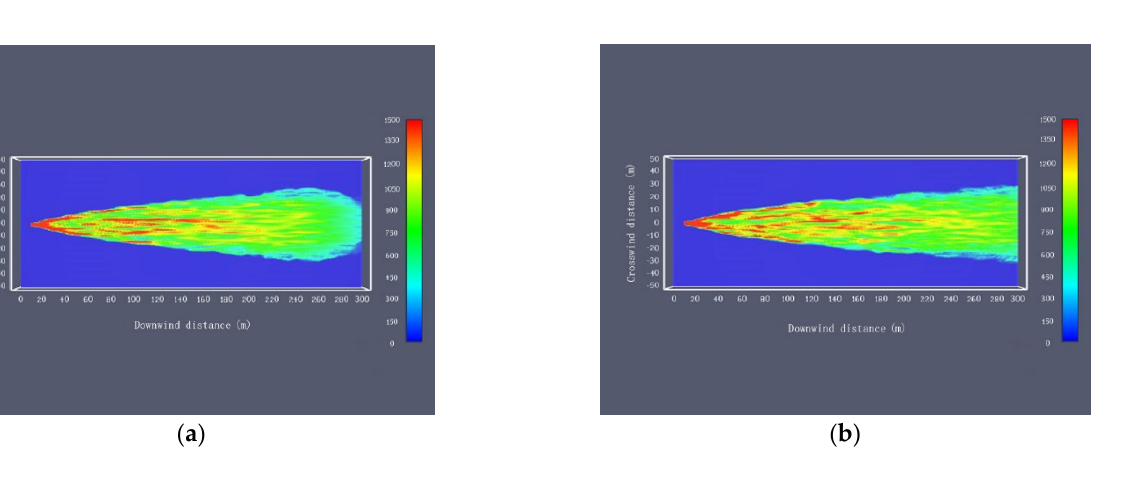
Figure 7. Concentration distribution diagram of MATLAB and FDS simulation methods in down- wind direction.